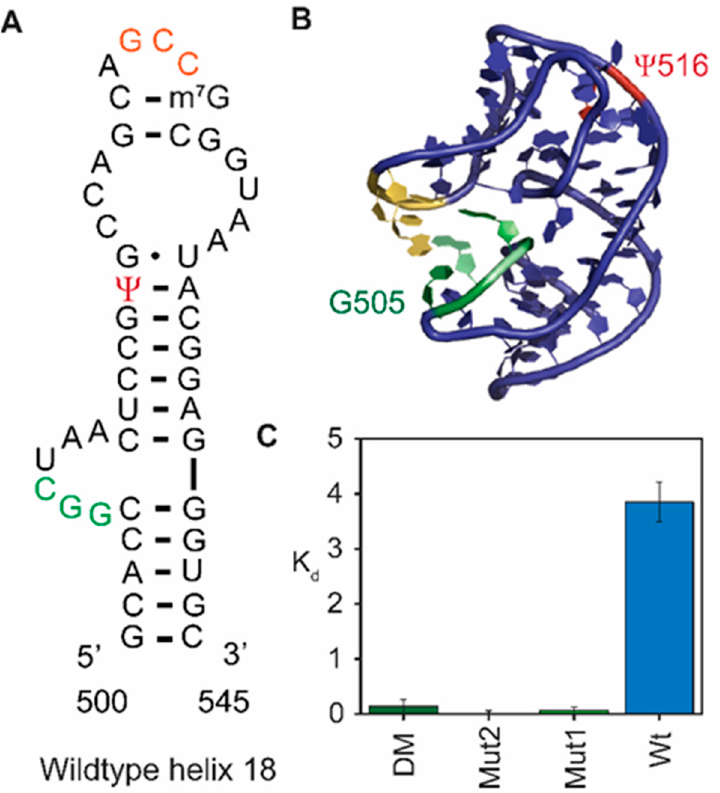
Figure 3. Protein RsuA preferably binds to helix 18 pseudoknot mutants compared to wild type 5 ′ -domain. E. coli 16S rRNA helix 18 ( A ) secondary and ( B ) Three-dimensional structures are shown. Pseudouridine modification at position 516 is shown in red. Nucleotides 505–507 (green) form base pairs with nucleotides 524–526 (yellow) to form the helix 18 pseudoknot. ( C ) Binding affinities of protein RsuA to wild type 5 ′ -domain and helix 18 mutants at 4 mM Mg 2+ are shown.